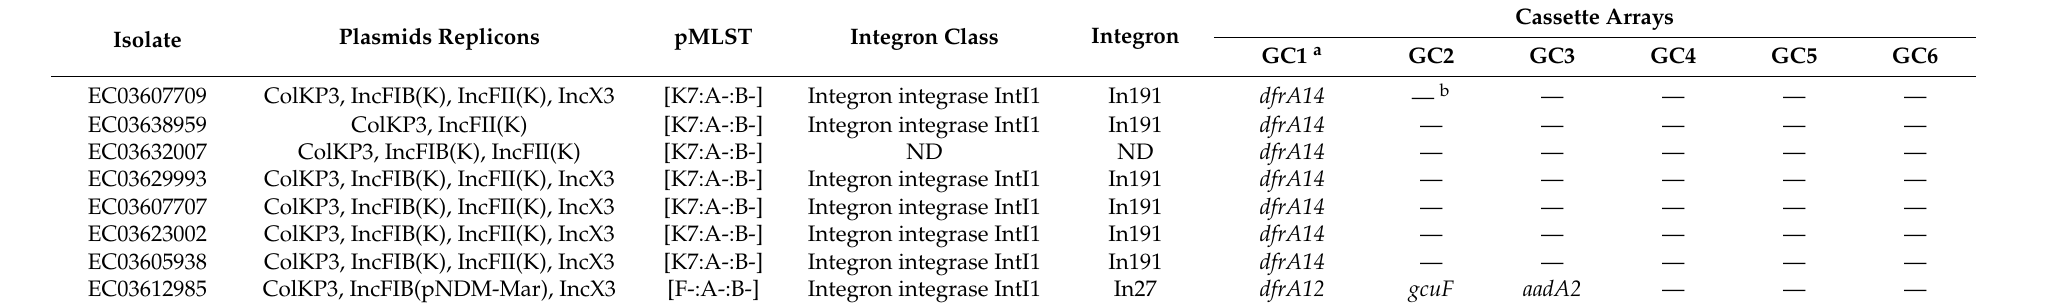
Table 2. Plasmid replicon types, class 1 integrons, and gene cassettes found in K. pneumoniae isolates.